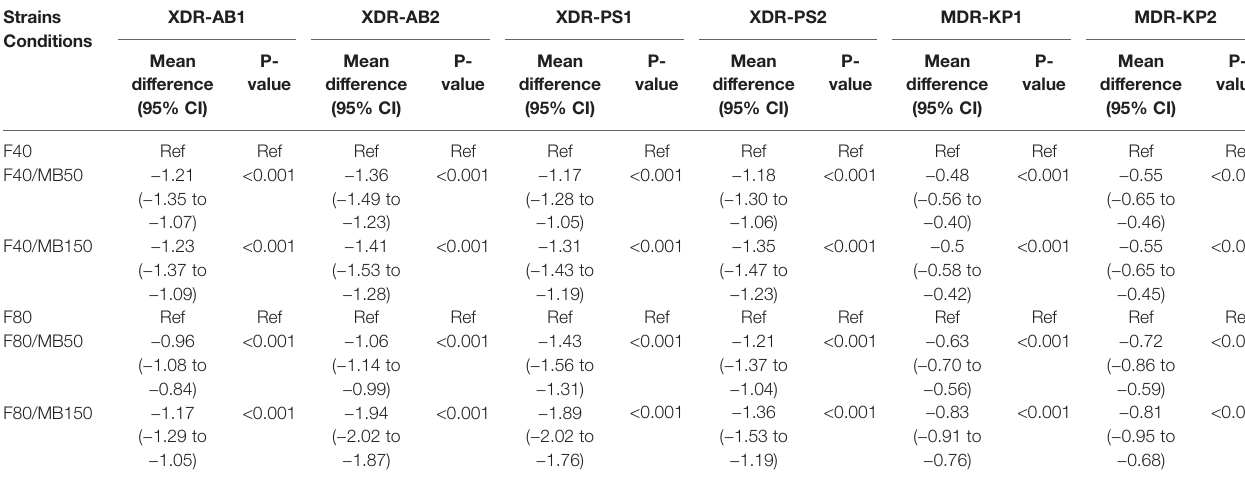
TABLE 2 | Comparison of Mean log 10 difference between the MB-aPDT and red light alone group for XDR-AB, XDR-PS, and MDR-KP. Strains